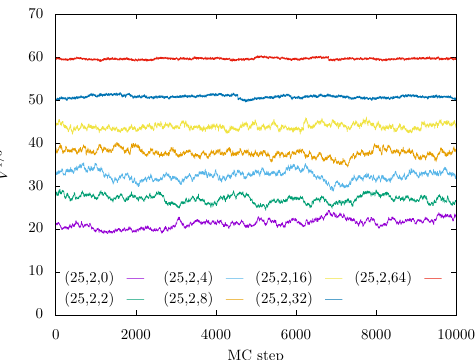
Figure 10. Traces of instantaneous box sizes during NPT Monte Carlo sampling for P = 0 and gel architectural parameters ( M , m , n ) , as indicated in the